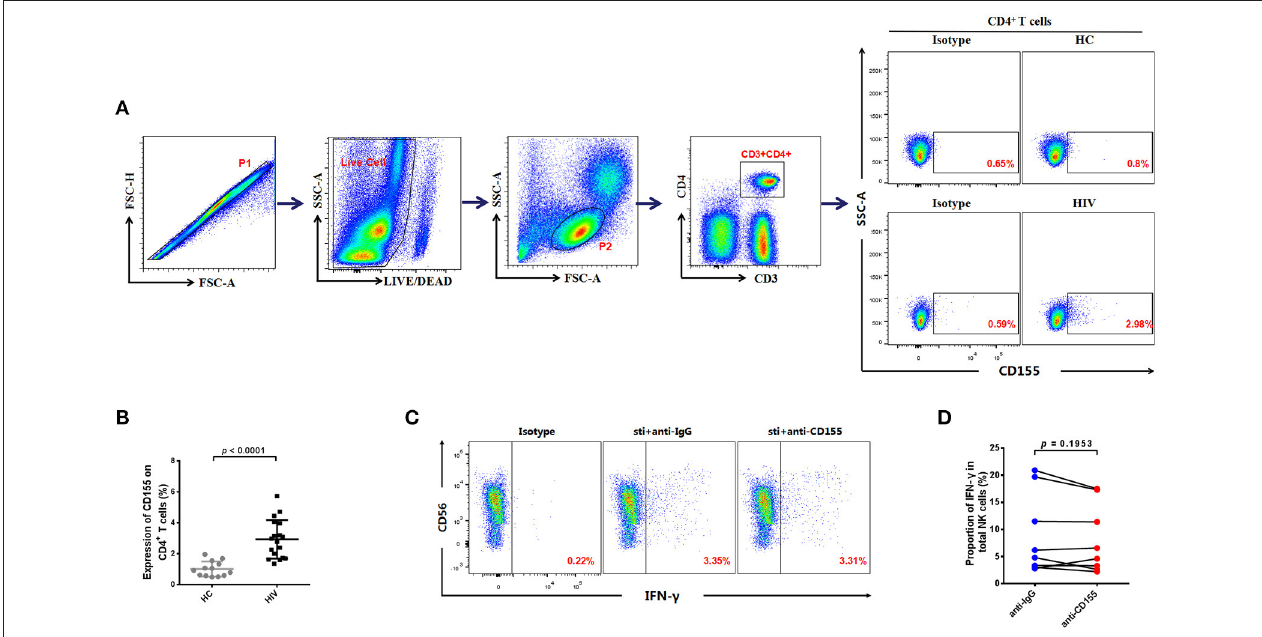
FIGURE 3 | Association between the expression of CD155 on CD4 + T cells and IFN- γ production by NK cells from HIV-infected individuals. (A) Gating strategy used to identify the CD4 + T cells. Single cells were gated using the forward scatter area (FSA) and forward scatter height (FSH) (P1), then live cells were gated by Live/Dead (BV510). Lymphocytes were gated according to forward scatter/side scatter properties (FSC/SSC) (P2). CD4 + T cells were identified from the CD3 − CD4 + gate. A representative flow cytometry plot showing the expression of CD155 on CD4 + T cells in HIV-infected and HC individuals. (B) Comparison of the percentages of CD155 expressing CD4 + T cells between HIV-infected ( n = 18) and HC ( n = 13) groups. (C) A representative flow cytometry plot showing production of IFN- γ in NK cells after treatment with 20 µ g/mL anti-human CD155 antibody or purified mouse IgG (as a negative control) from HIV-infected individuals; the production of IFN- γ was gated according to an isotype control. (D) Paired comparison of the production of IFN- γ by NK cells after treatment with 20 µ g/mL anti-human CD155 antibodies or purified mouse IgG (as a negative control) from HIV-infected individuals ( n = 8). The Mann-Whitney U test was used for comparisons between two groups. The Wilcoxon matched-pairs signed-rank test was used for paired-group comparisons. p < 0.05 was considered